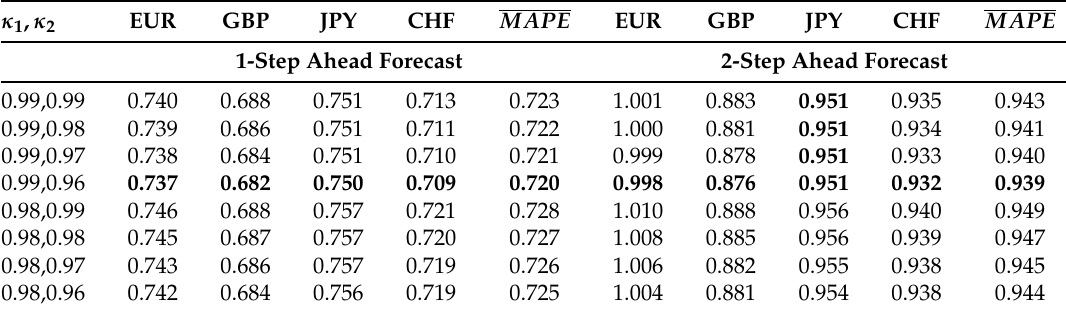
Table 4. Forecast comparison using MAPE